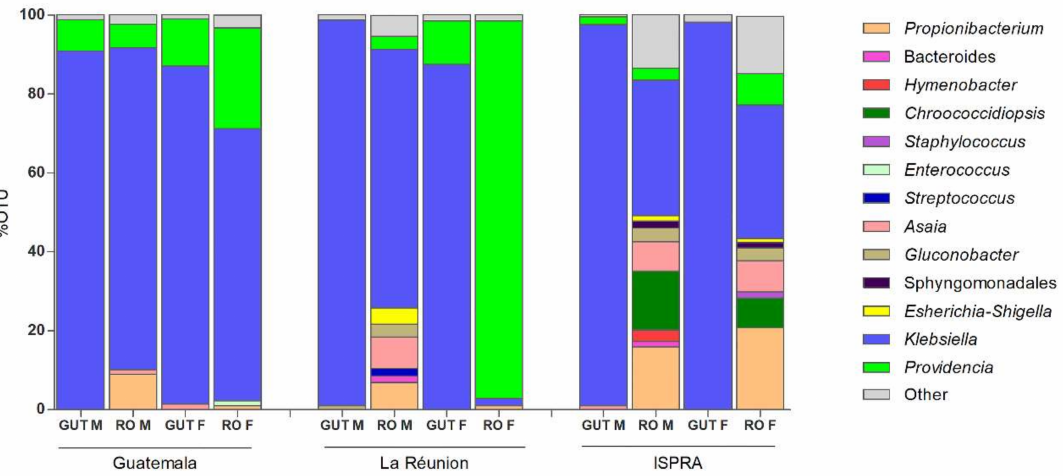
Figure 2. Genus level composition (% of OTUs) in different organs of C. capitata. Only OTUs representing >1% of the total reads are represented. RO: reproductive organs; M: male; F: female. Gluconobacter was mostly detected in the males (guts: 1% and reproductive organs: 3.2%) of the La R é union population and in the male (3.6%) and female (3.2%) reproductive organs of the ISPRA